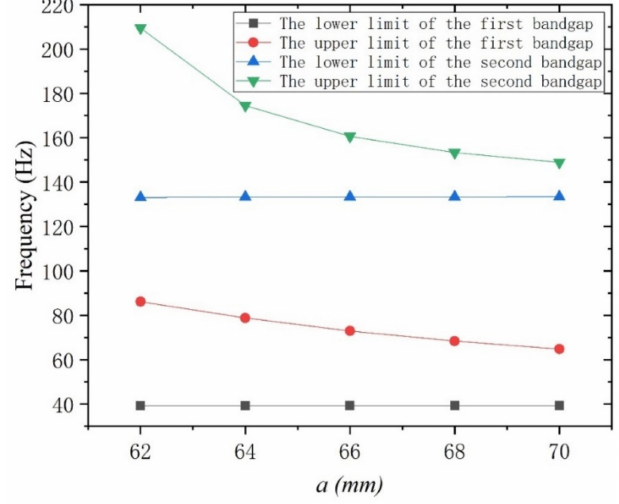
Figure 12. The impact of the lattice constant a on band